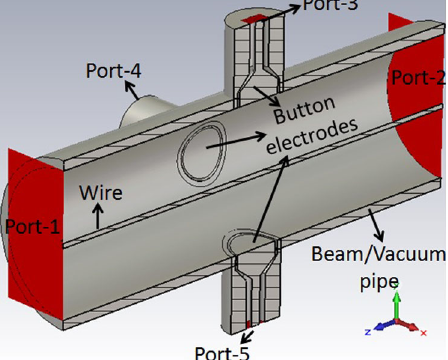
FIG. 6. CST model for the simulation of the conventional coaxial wire method used for the calculation of transfer imped- ance of the test BPM.